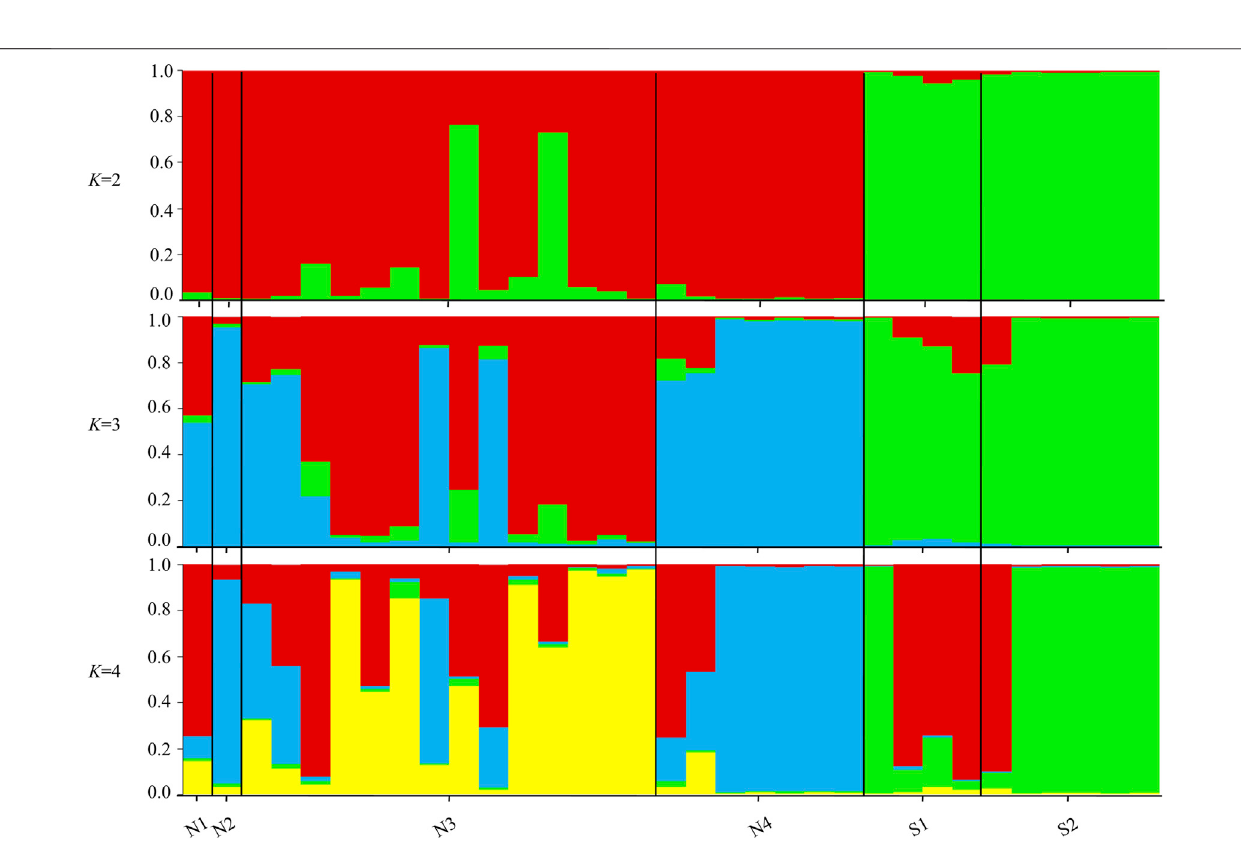
Frontiers in Genetics |